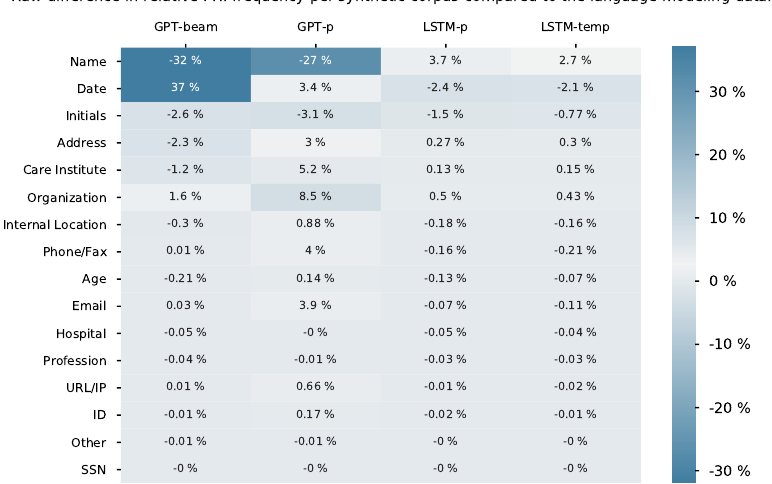
Figure A2. Raw increase/decrease in relative PHI frequency per synthetic corpus compared with the PHI distribution of the language modeling corpus. Raw numbers for Figure